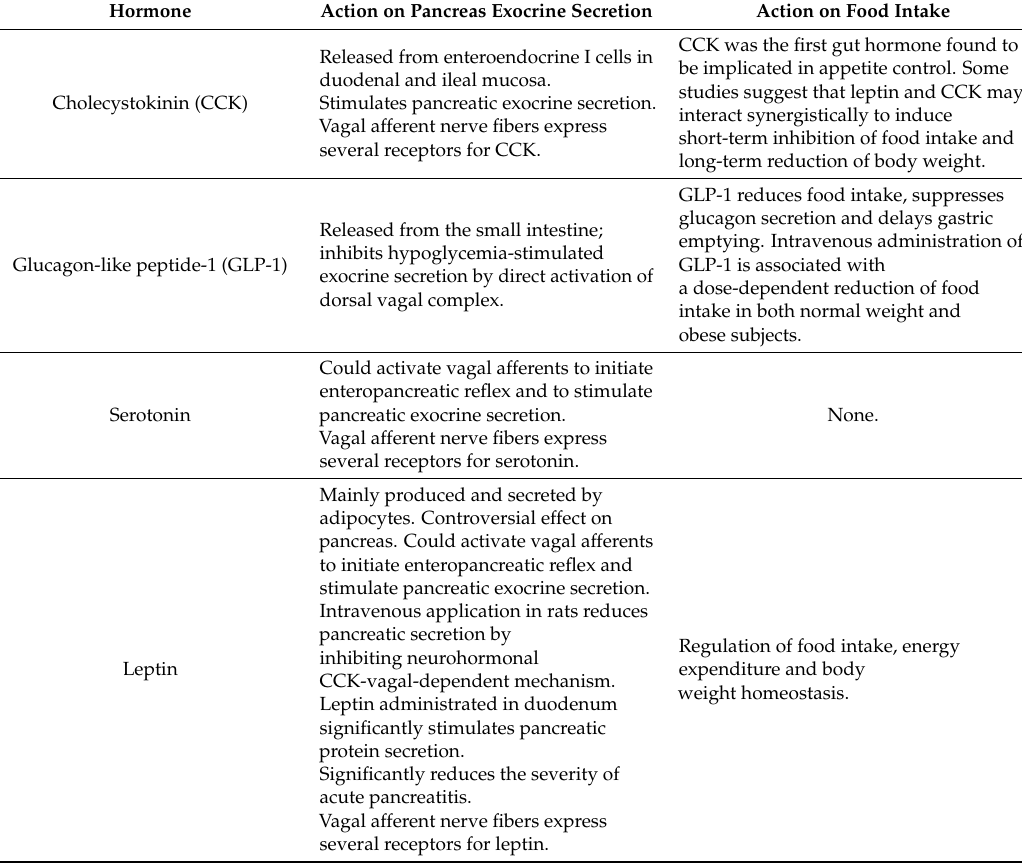
Table 1. Role of hormones on pancreatic exocrine function and food intake [4,5,7,15,16].